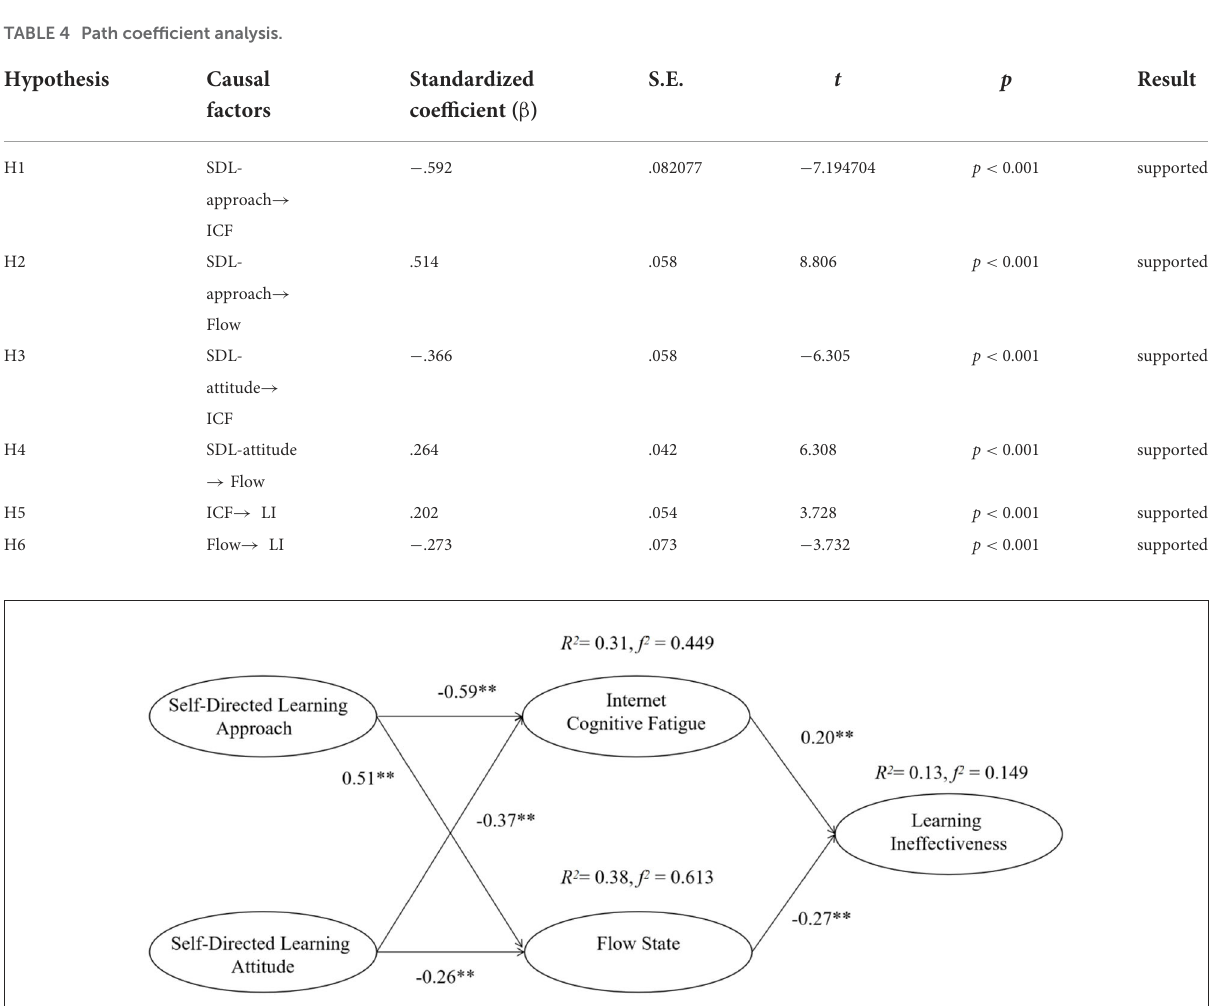
related to ICF but positively related to Flow, whereas SDL attitude is negatively